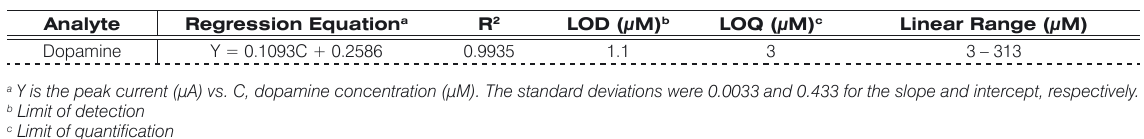
Table 1. Characteristics of the dopamine individual calibration